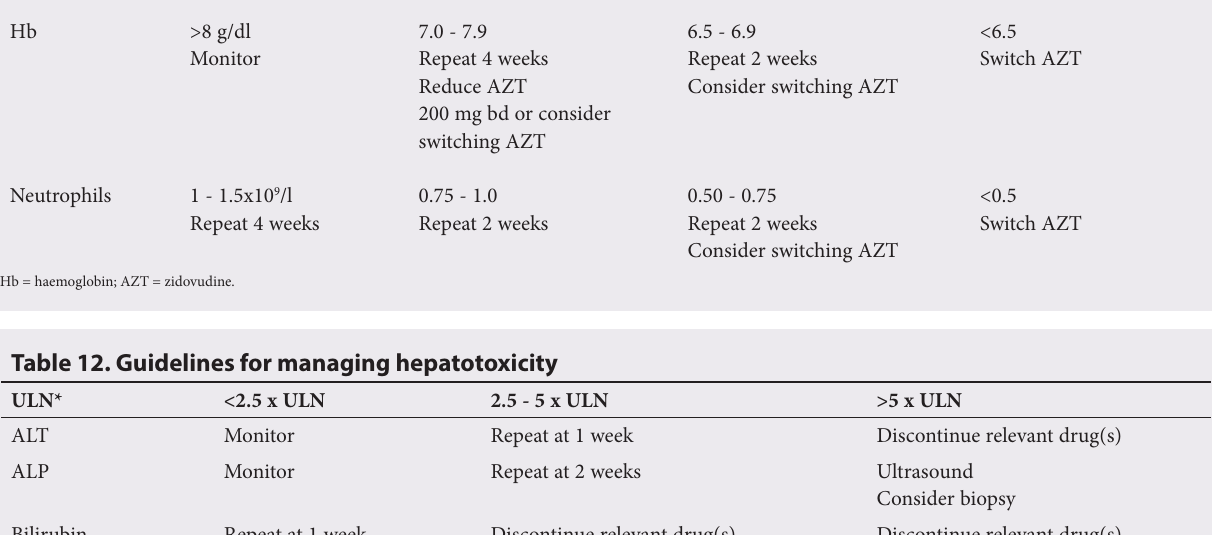
Table 11. Guidelines for managing haematological toxicity (mainly AZT-induced)